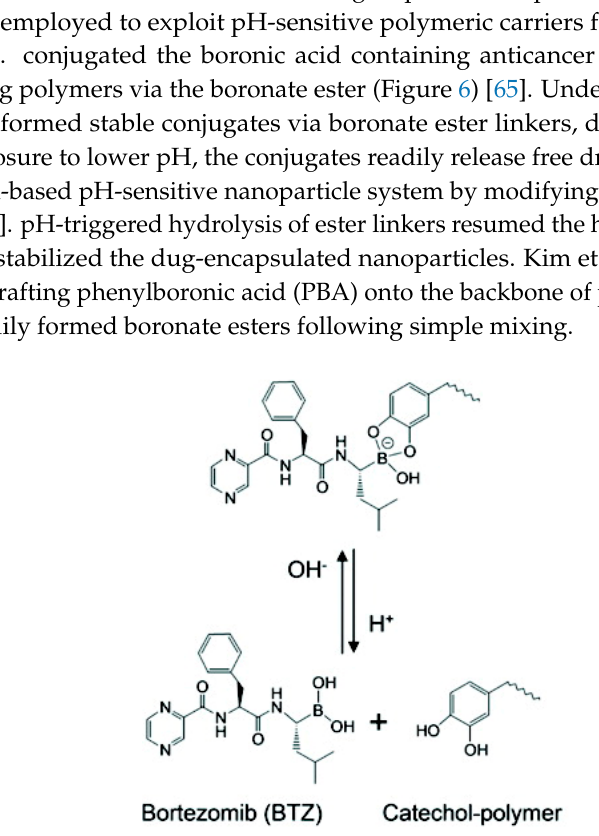
Figure 5 . Schematic illustration of the envelope-type mesoporous silica nanoparticle for pH-